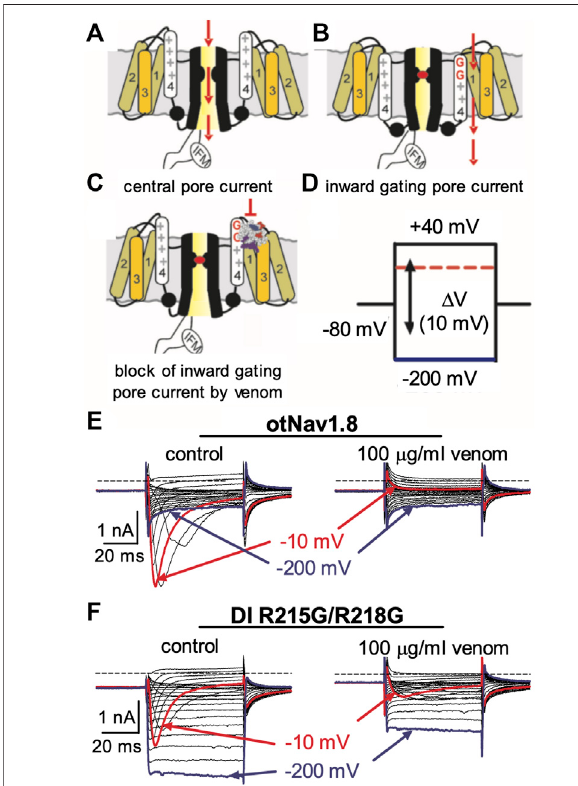
FIGURE8| EffectsofAZbarkscorpionvenomonDIIinwardgatingpore currents. Gating pore currents were generated by glycine mutation of the fi rst andsecondgatingcharges(twooutermostarginineresidues)onOtNa V 1.8DII S4 (R756G/R759G). A typical protocol was used to elicit inward gating pore current (see schematic, Figure 6D ). Cells held at − 80 mV were stimulated by 50-ms hyperpolarizing steps to various potentials that ranged from – 200 to +40 mV in 10-mV increments. As observed for wildtype OtNa binding af fi nity. Blue and red traces represent typical leak current (gating pore current) and central pore current at − 200 and − 10 mV,